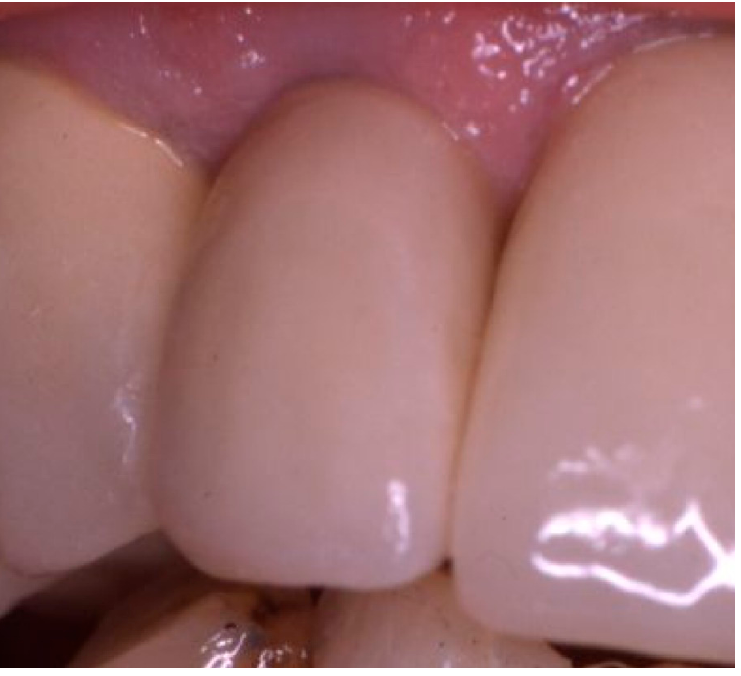
Figure 4. Example of opaque tooth image.